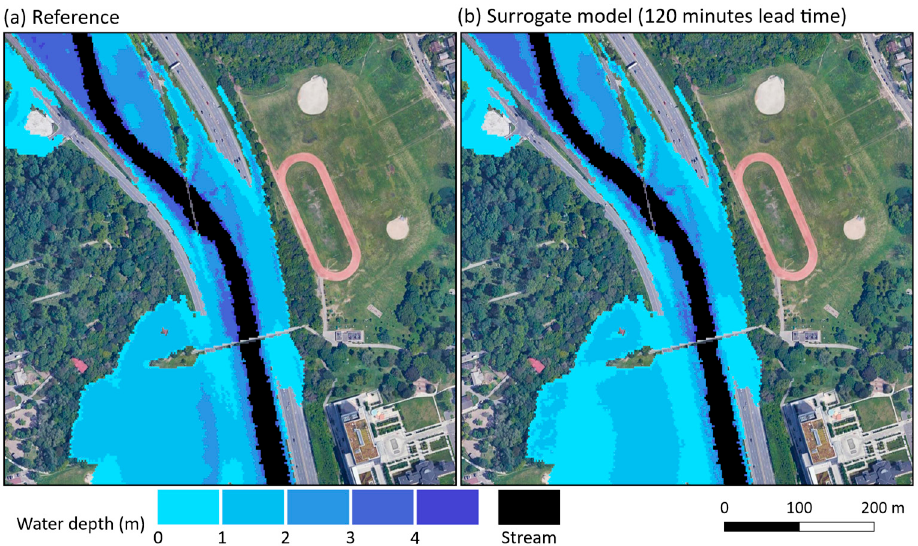
Figure 12. Flood inundation maps centered in the POI 2 of the Figure 11g ( a ) and of the Figure 11a ( b ) applied to a Google Earth satellite image (© 2021 Google).